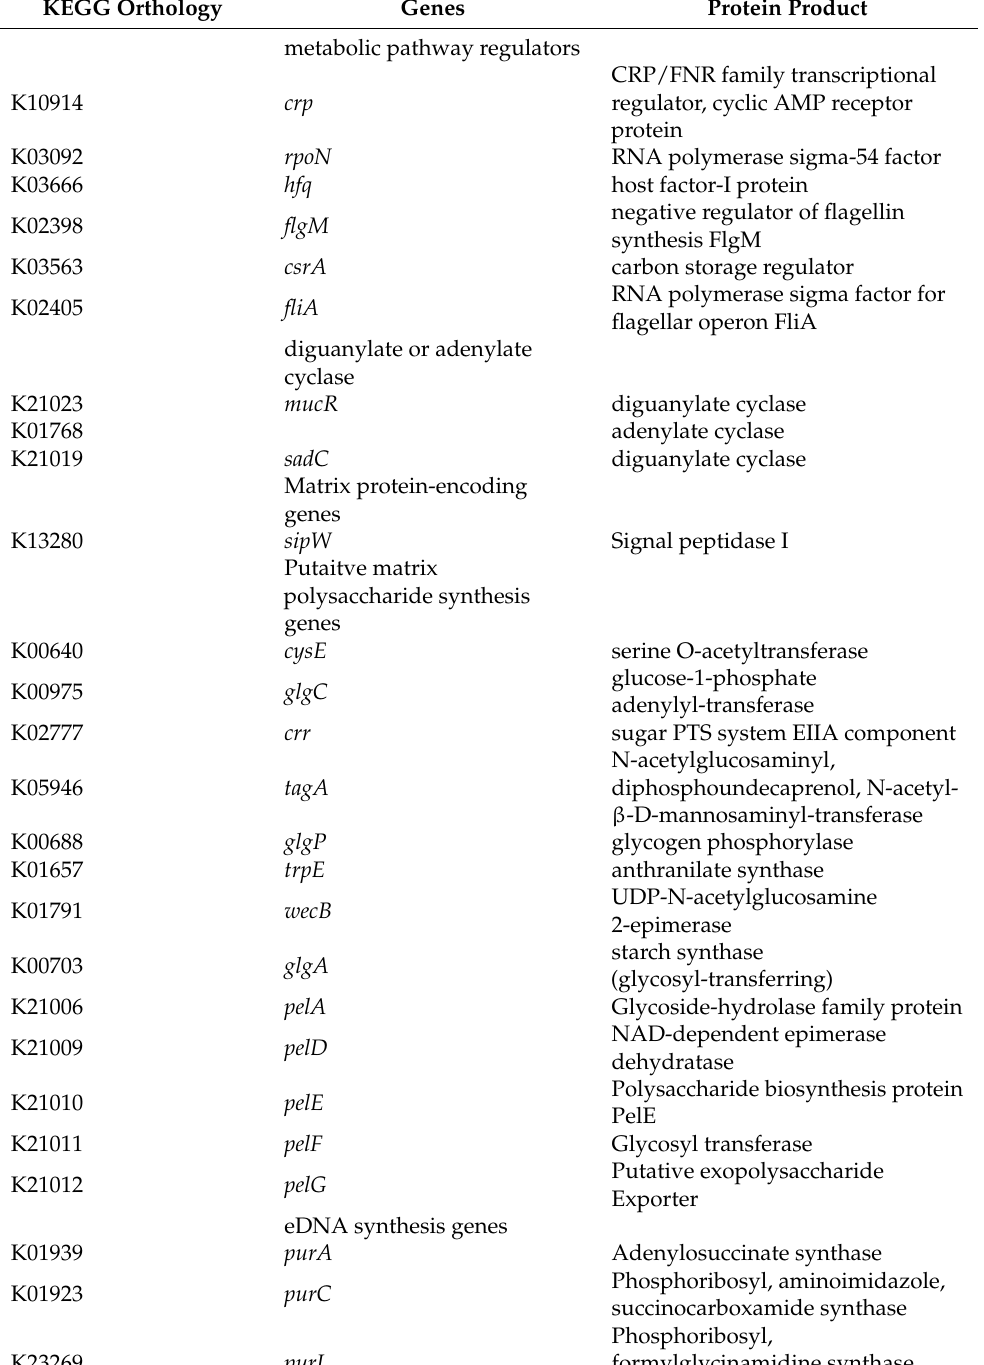
Table 7. Putative biofilm formation-related genes in P. mucilaginosus